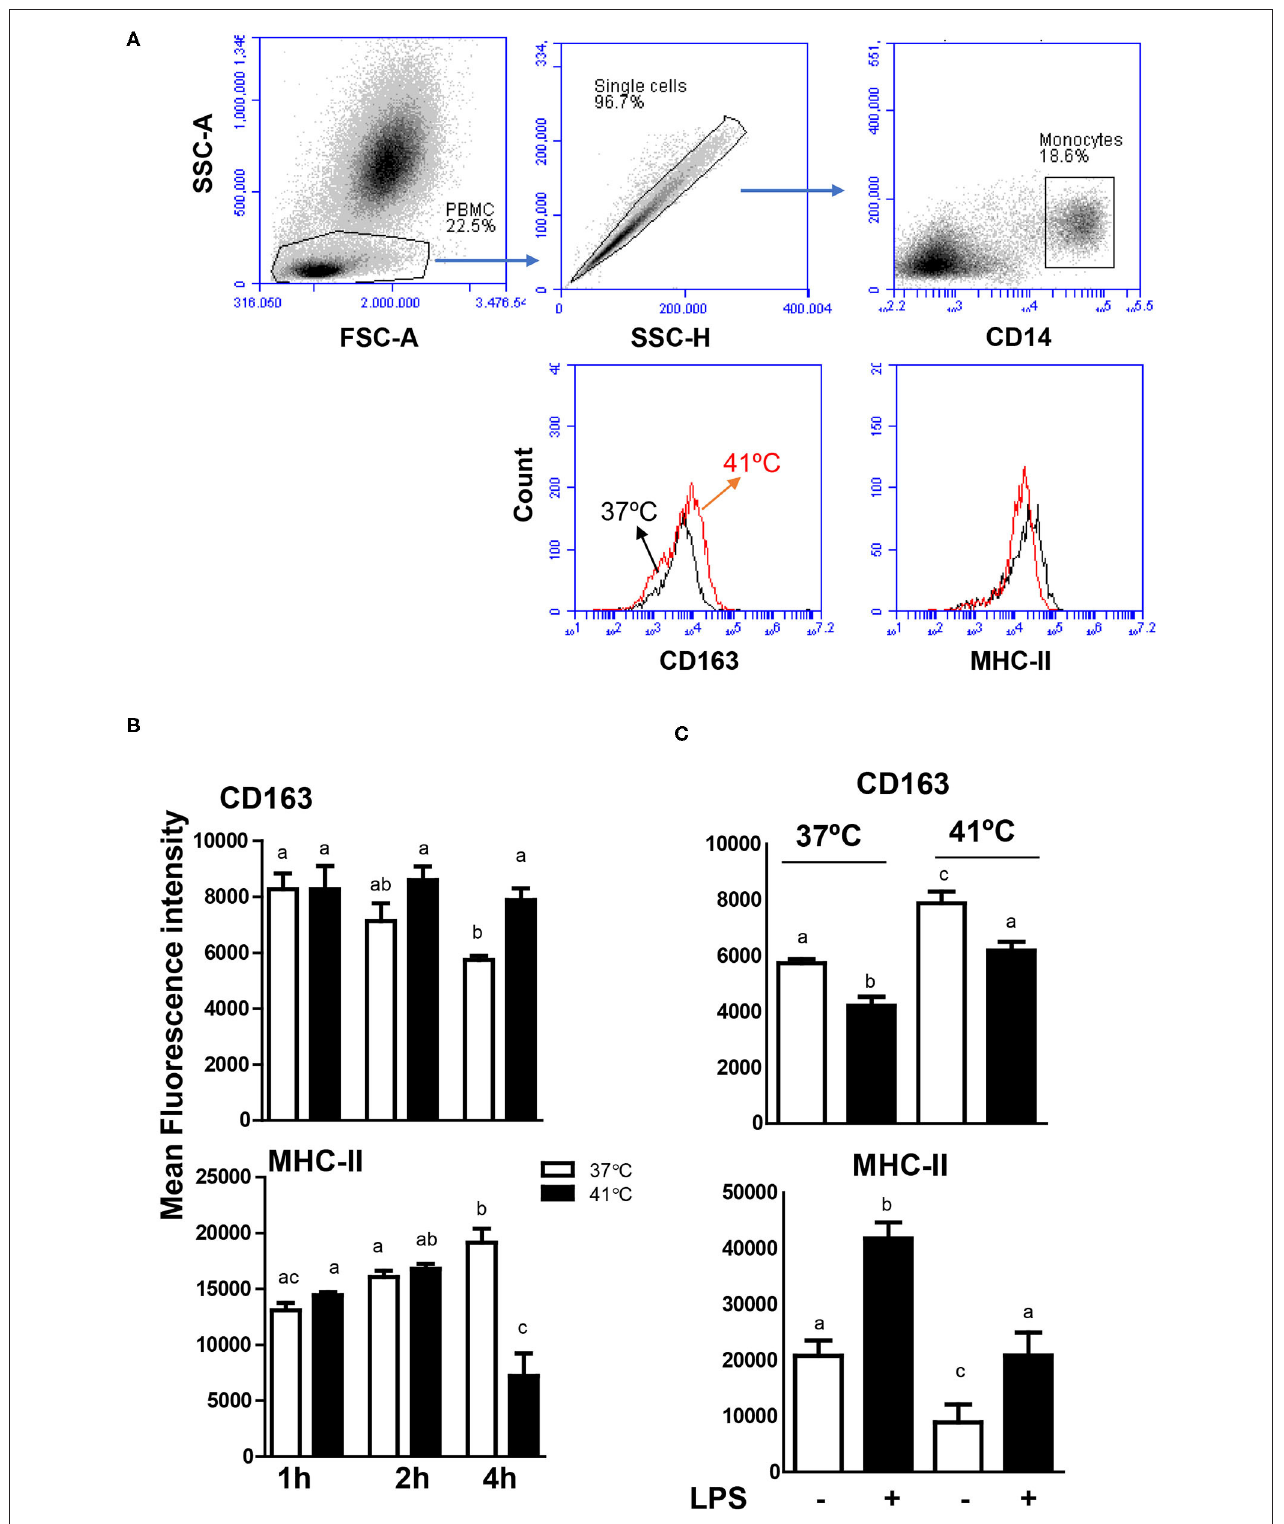
FIGURE 6 | Modulatory effects of heat stress on the phenotype of camel monocytes. (A) Gating strategy for the flow cytometric analysis of expression of CD163 and MHC class II molecules on camel monocytes. Separated camel leukocytes were labeled with monoclonal antibodies to CD14, CD163, and MHC class II molecules and analyzed by flow cytometry. Monocytes were identified as CD14-positive cells within mononuclear cells after excluding cell duplets using SSC-A/SSC-H dot plot.